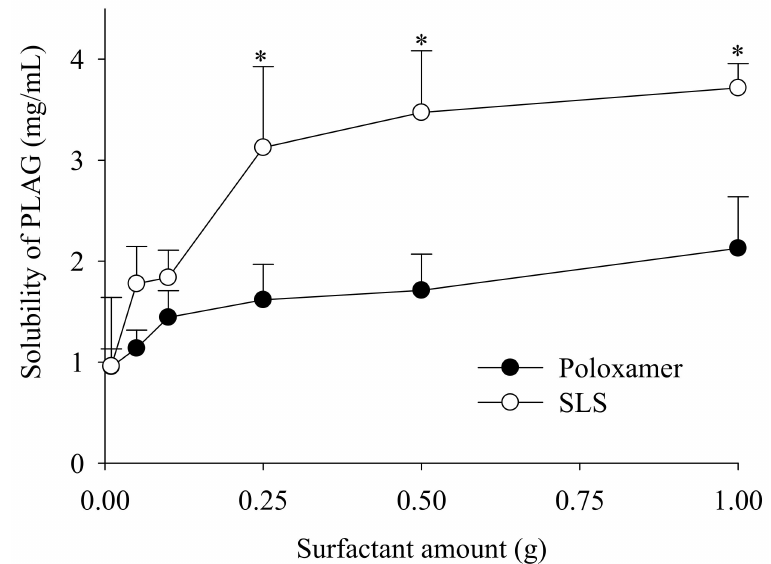
Figure 2. E ff ect of surfactant on the drug solubility. Various amounts (0.5–5%) of surfactants, such as poloxamer and sodium lauryl sulphate (SLS), were used. Each value designates the mean ± S.D. ( n = 3). * p < 0.05 compared with